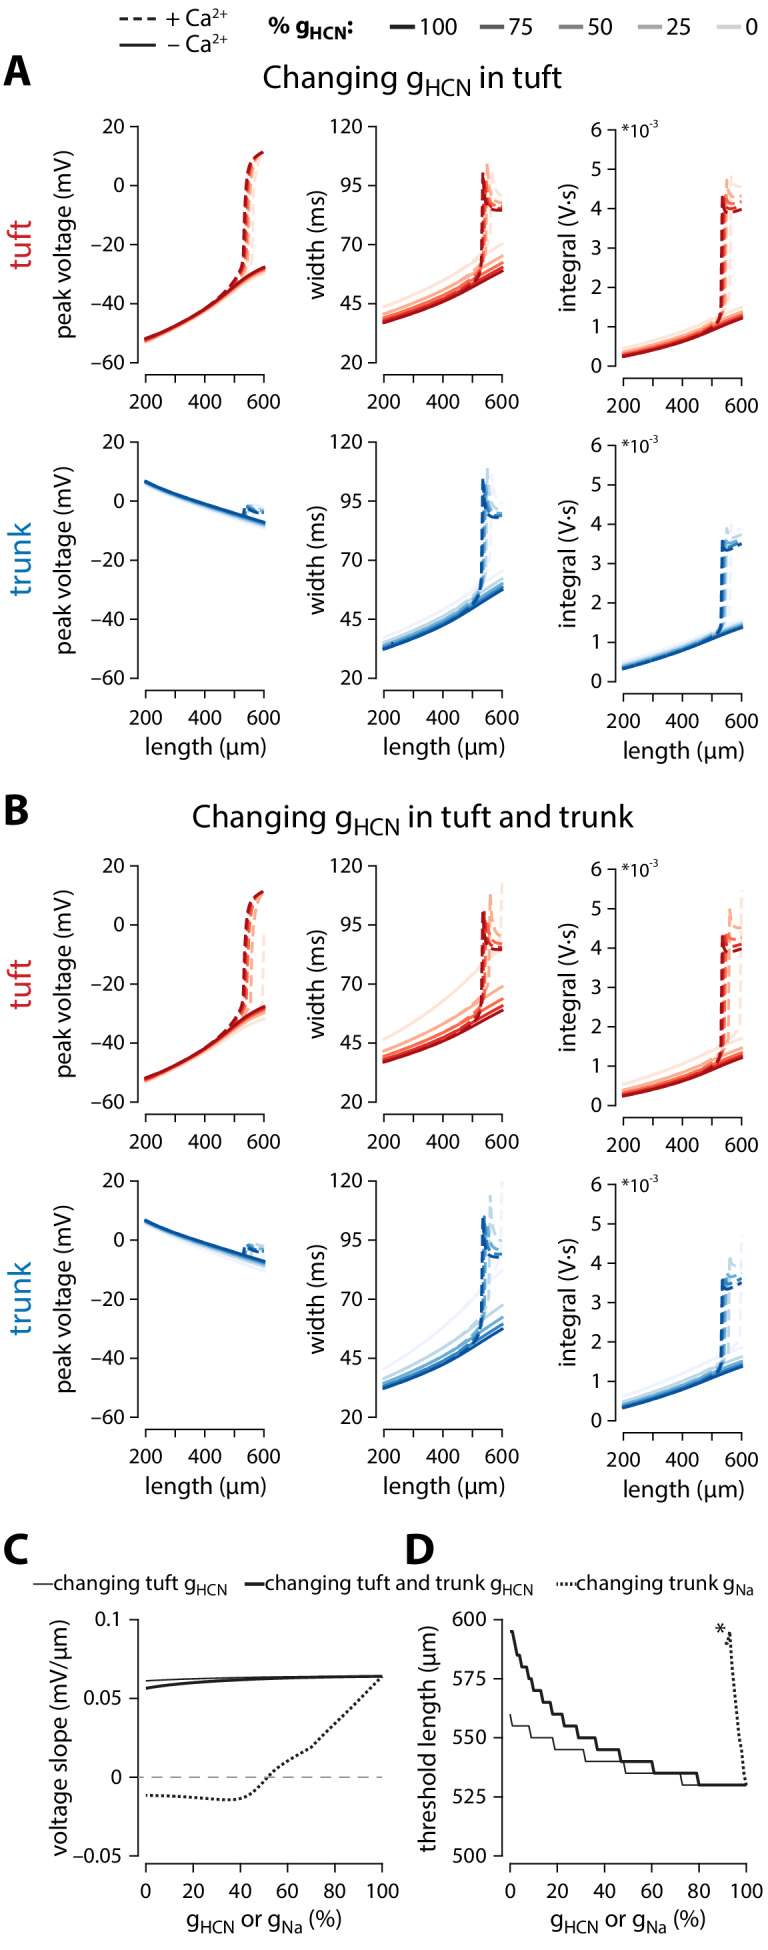
Ih is not critical to the length dependence of Ca2+ electrogenesis.(A) Plots of peak voltage, width and integral of bAPs under different relative gHCN (shades) in the tuft, both in the presence (dashed) or absence (solid) of Ca2+ channels. (B) Same as A, but varying gHCN in both tuft and trunk compartments. (C) Slope of tuft voltage vs apical trunk length plotted at different gHCN (from panel B) or gNa (from Figure 4E) values. (D) Threshold length for dendritic Ca2+ electrogenesis at different gHCN values. N.B. there is no dendritic Ca2+ electrogenesis under 0.91 gNa (marked with asterisk). Simulations were run in 5 µm trunk length and 1% conductance steps.